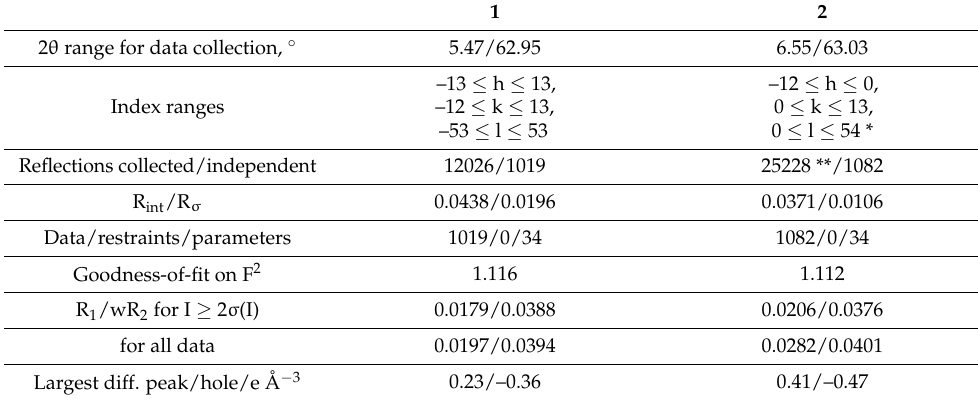
Figure 2. Crystal packing in the structures of 1 and 2 . C and H: grey, N: deep blue, metal: black, Cl: light green. Figure 3. Experimental PXRD pattern of the sample of 1 after 1 h (blue) and calculated patterns of 1 (black) and “dichlorine-free” (Me 3 NH) 2 [SnCl 6 ] (red).